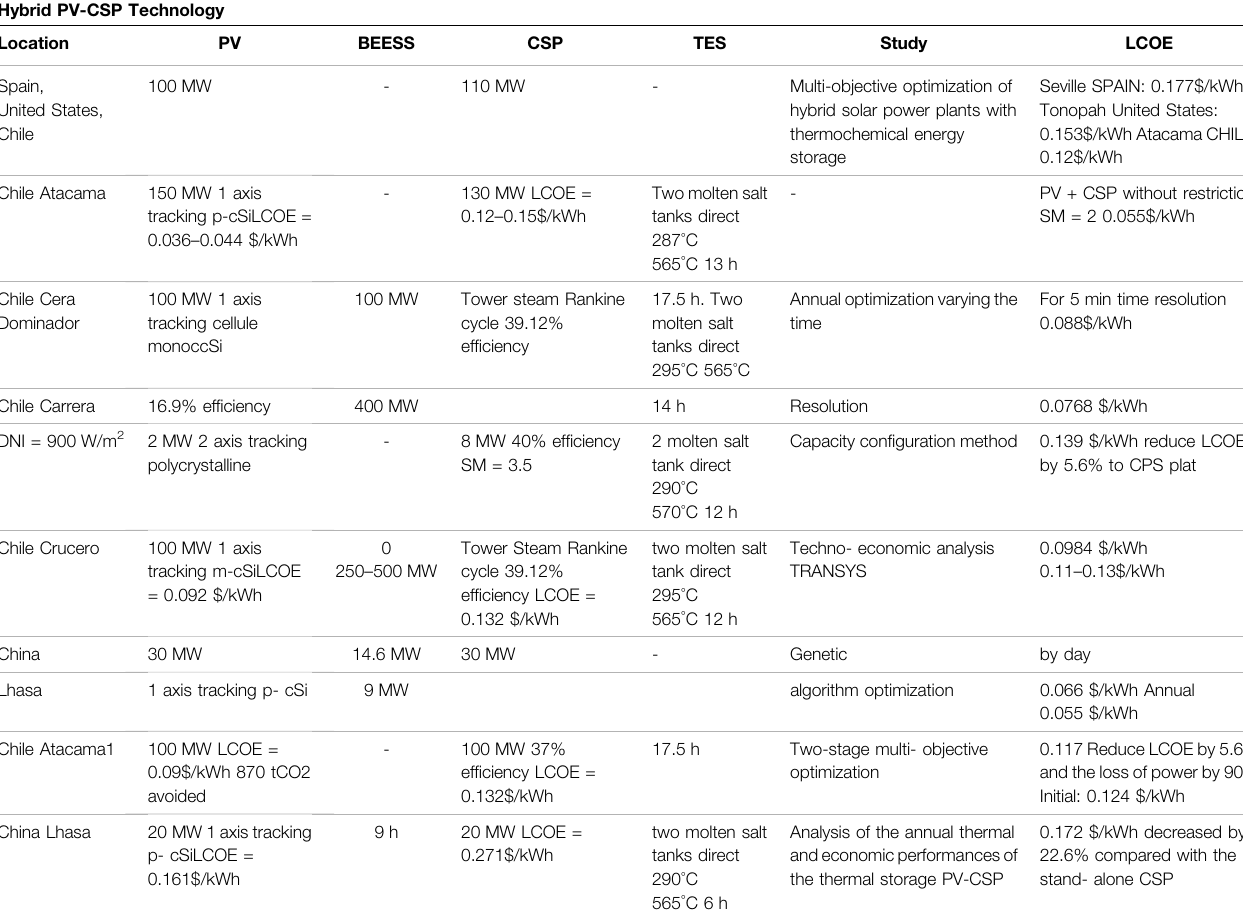
TABLE 3 | Hybrid PV-CSP technology (Zineb et al., 2021). Hybrid PV-CSP Technology Location